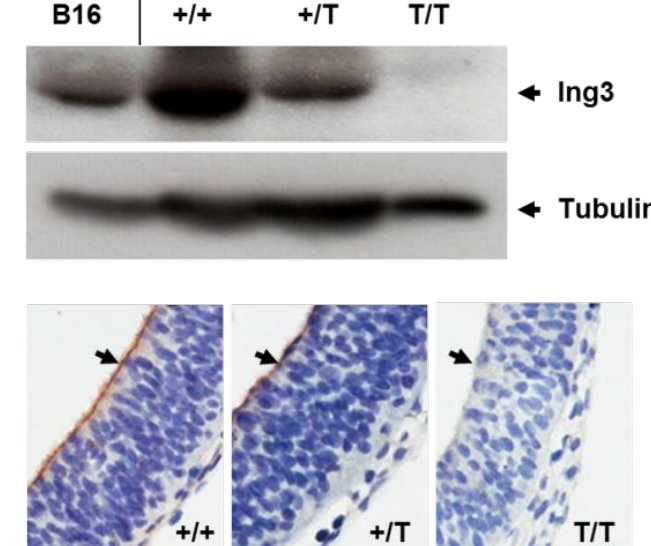
Figure 2. Protein expression in whole E10.5 embryos and the developing brain of E10.5 embryos. ( A ) Western blot analysis for ING3 of wild type (+/+; n = 1), heterozygous (+/T; n = 1), and homozygous (T/T; n = 2) whole embryos and intensity ratio readings ING3/Tubulin. ( B ) Immunohistochemisty for ING3 of wild type (+/+; n = 2), heterozygous (+/T; n = 2), and homozygous (T/T; n = 1) embryos. A representative section of the developing brain is shown and indicated by arrows. Magnification 40×.